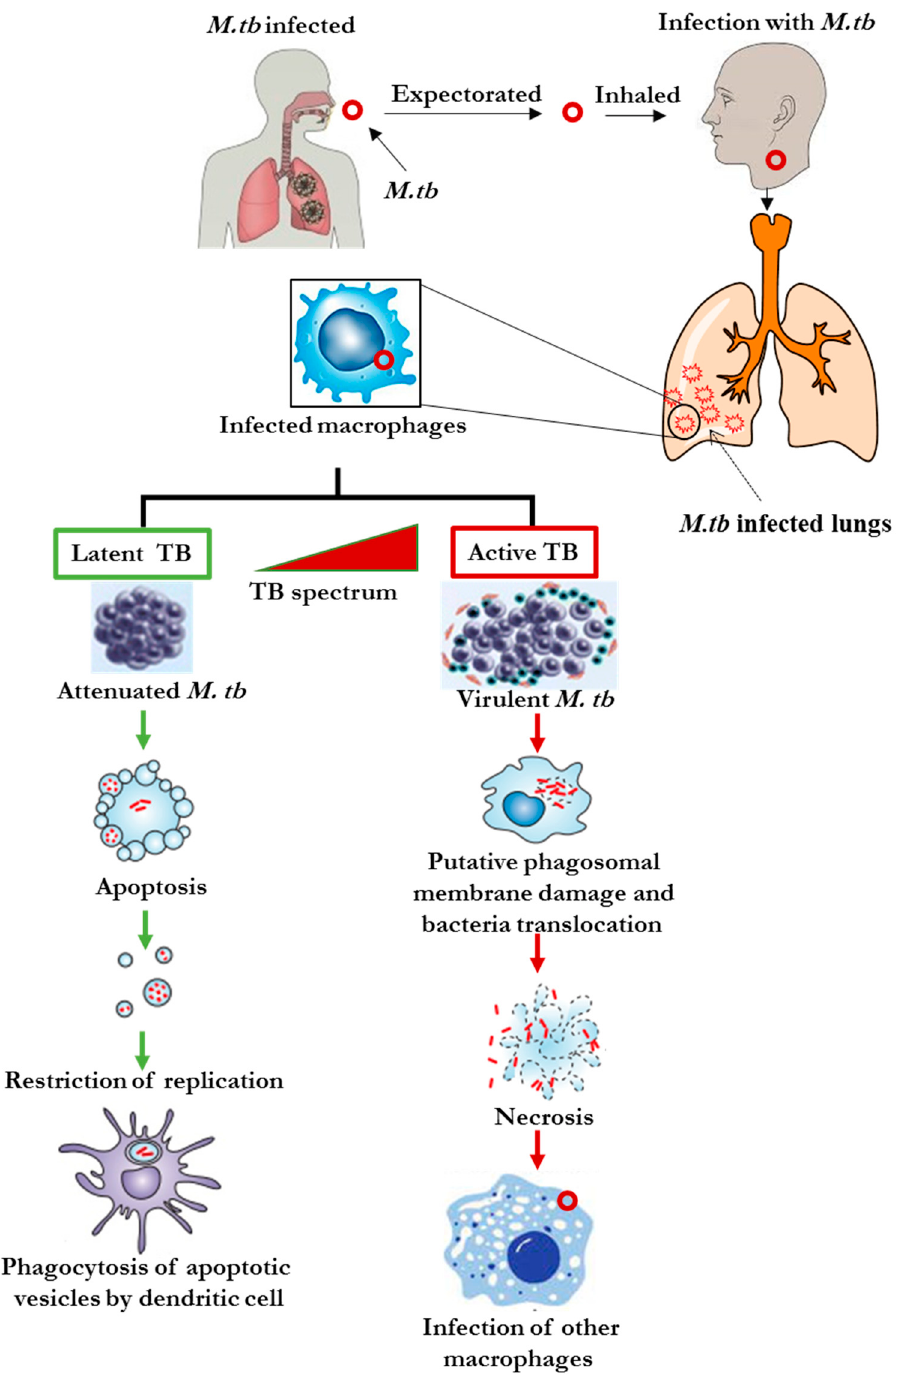
Figure 1. Stages of the TB infections, depicting the latent and active stages.